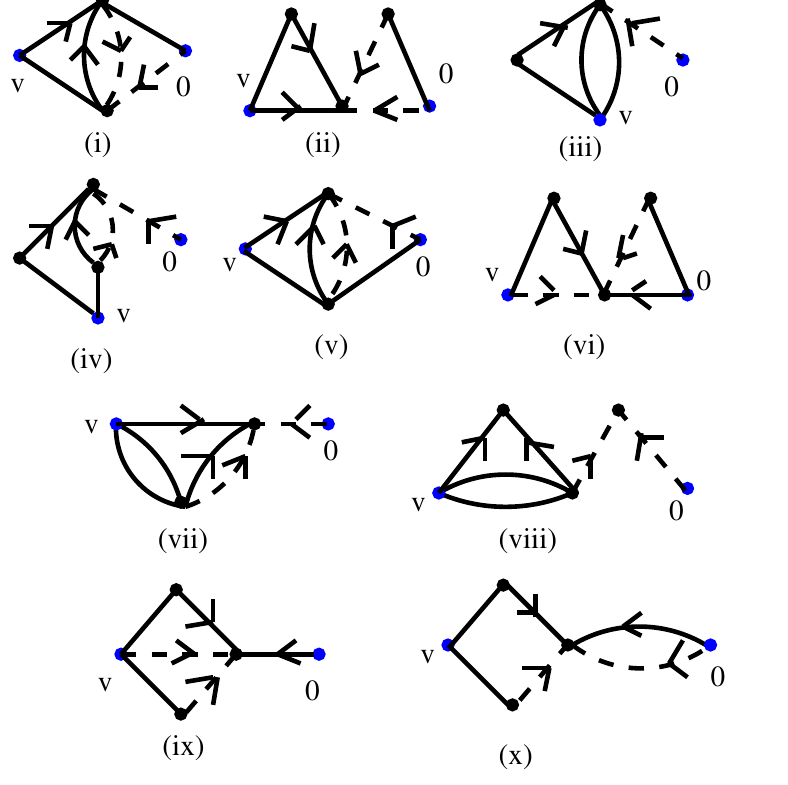
Figure 7 . The graphs (i) π 2 H 1 ( v ) , (ii) π 2 H 2 ( v ) , (iii) πH 3 ( v ) , (iv) π 2 H 4 ( v ) , (v) π 2 H 5 ( v ) , (vi) π 2 H 6 ( v ) , (vii) π 2 H 7 ( v ) , (viii) π 2 H 8 ( v ) , (ix) π 2 H 9 ( v ) , (x) π 2 H 10 ( v )